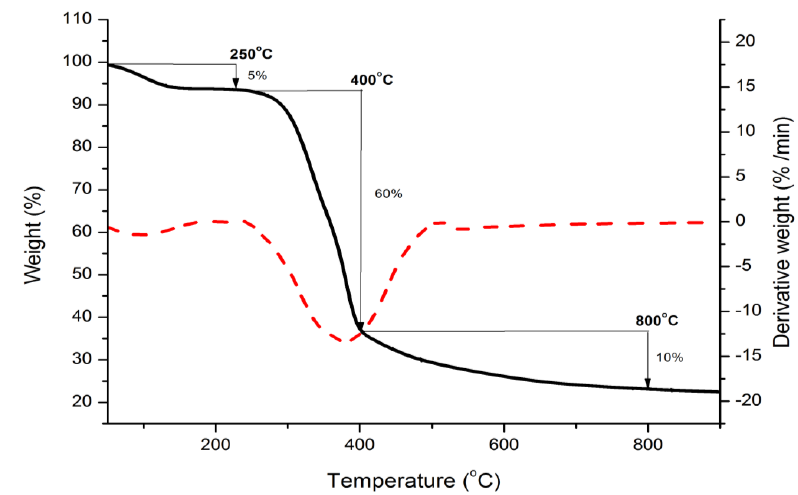
Figure 3. TGA/DTG curve of raw RSS.